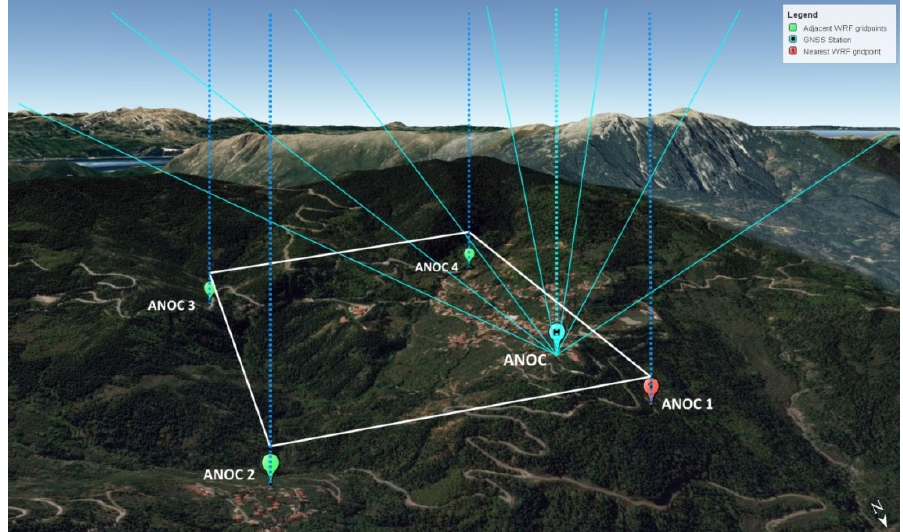
Figure 2. Example of GNSS-WRF geometry for ANOC Station (h = 1020 m). Dark blue dotted lines depict the ZTD path calculated by WRF at the four nearest grid points, light blue lines depict the GNSS slant paths measured by the receiver at the time of acquisition and light blue dotted line depicts the ZTD path calculated by the GIPSY tropospheric processing.